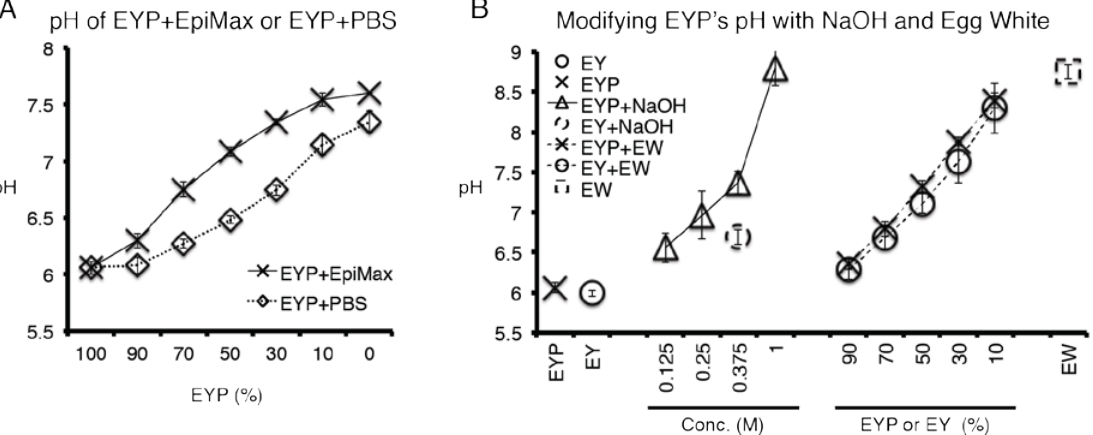
Figure 3. Graphs Showing EYP’s pH Change When Combined with Medium, NaOH and Egg Whites. ( A ) EYP diluted with different concentrations of Epimax medium and PBS. ( B ) NaOH and EW’s effect on EYP and Egg Yolk’s (EY) pH. In these experiments, all tubes contained 5 mL of EYP or EY. Then for the Conc. experiment, 0.25 mL of the shown concentration was added to 5 mL of either EYP or EY. For the EW experiment, EW quantities were added to the initial volume of 5 mL, increasing EW percentage. All pH measurements were conducted at 37°C with a pH meter and probe. Error bars are standard deviation.